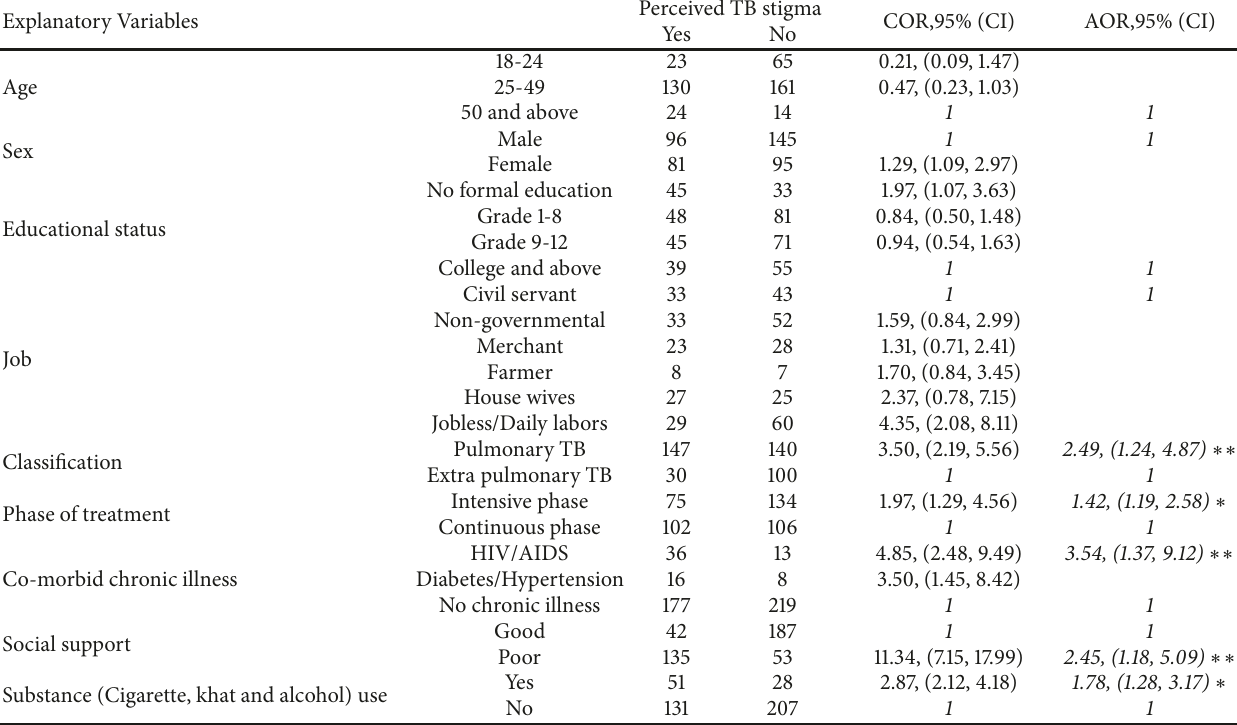
Table 2: Factors associated with TB related perceived stigma among patients with TB at Wolaita Sodo University Referral Hospital, Wolaita Sodo, Ethiopia, 2016,